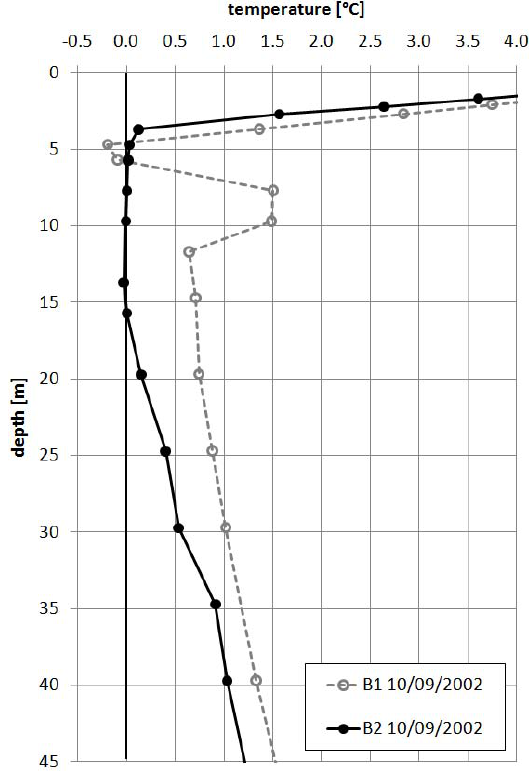
Fig. 9. Borehole temperatures at Muragl rock glacier (taken from the PERMOS network, data obtained by Geotechnical Institute, ETH